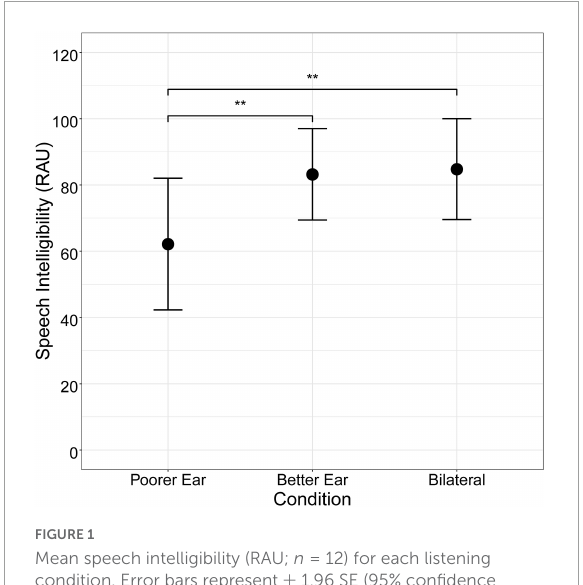
FIGURE1 Mean speech intelligibility (RAU; n = 12) for each listening condition. Error bars represent ± 1.96 SE (95% confidence interval). Asterisks indicate the significance level of pairwise comparison results (* for p < 0.05, ** for p < 0.01, and *** for p < 0.001).